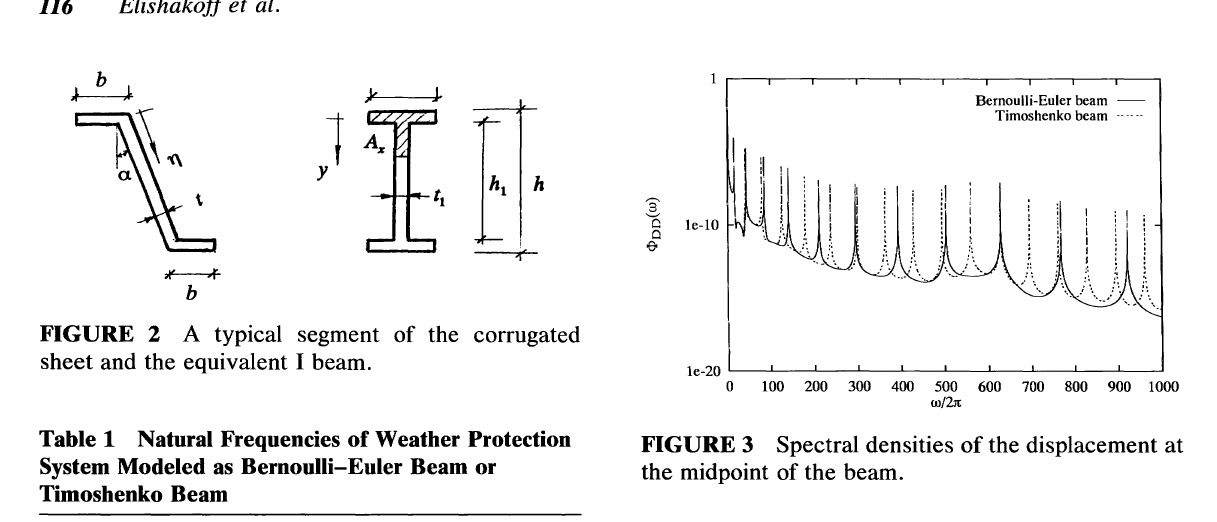
FIGURE 3 Spectral densities of the displacement at the midpoint of the beam.